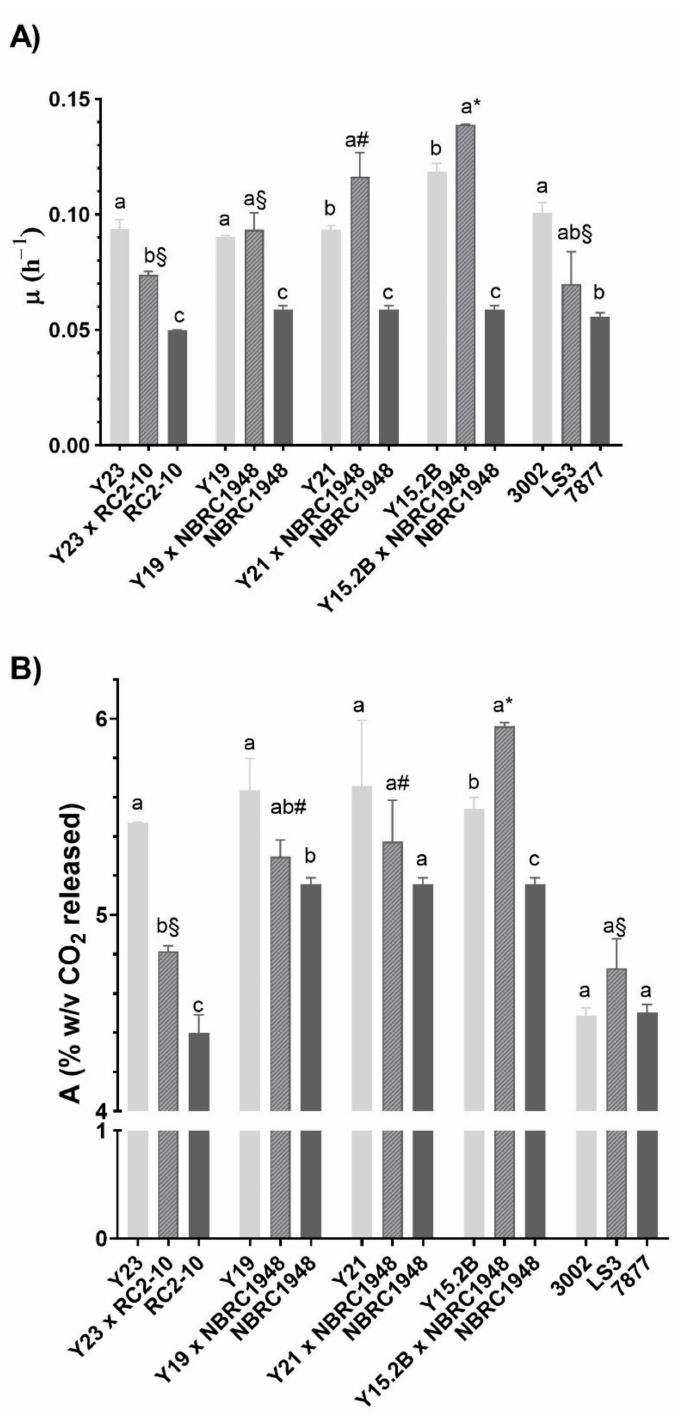
Figure 4. Values of maximum fermentation rate µ (h − 1 ) ( A ) and maximum fermentation level A (% w / v CO 2 ) ( B ) in laboratory-scale wort fermentation (15 ◦ P, 20 ◦ C). S. cerevisiae , hybrids and S. bayanus / S. uvarum are represented as solid light gray, hatched gray and solid gray columns, respectively. Different letters indicate significant differences ( p < 0.05) within each triad of hybrid and parents based on one-way ANOVA; different symbols (§, # and *) indicate significant differences ( p < 0.05) among hybrids Y23 × RC2-10, Y19 × NBRC1948 and Y15.2B × NBRC1948 based on one- way ANOVA. Superscript letters were attributed as follows: the highest value was marked as “a,” the next value that is significantly different can be “b,” and so